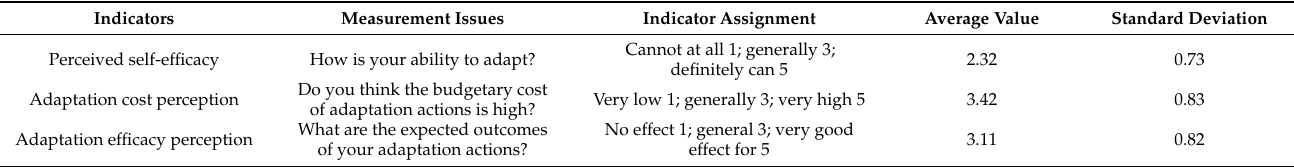
Table 1. Descriptions of explanatory variables.